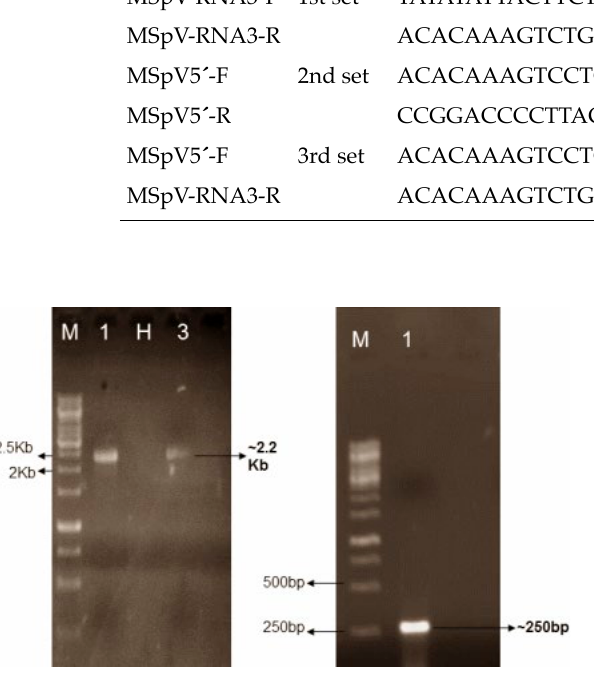
Figure 2. PCR amplicons resolved by 1% agarose gel elec - trophoresis. (a) The PCR amplification of ≈2.2 kb with first set of primers. Lane M, 1 kb Fermentas DNA ladder; lane H, healthy control; lane 1 and 3, samples with 2.2 kb am - plicons. (b) PCR amplification with second set of primers. Lane M, 1 kb Fermentas DNA ladder; lane 1, amplicons of ≈250 bp covering the